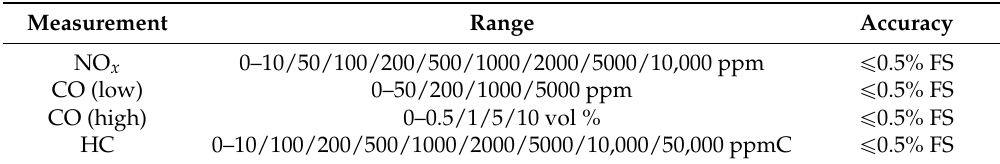
Table 2. Specifications of the HORIBA 7100 emission analyzer. Full scale: FS.